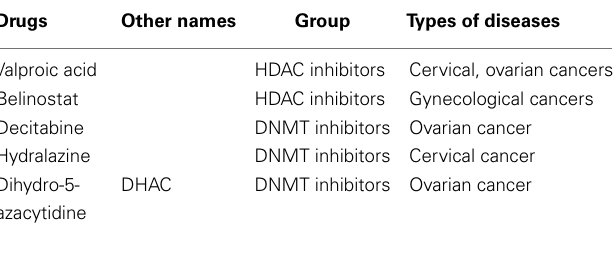
Table 2 | Epigenetic drugs in gynecological cancer